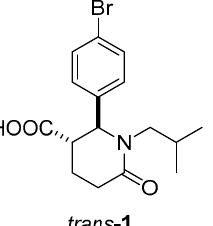
Figure 3. Structure of trans -2-(4-bromophenyl)-1-isobutyl-6-oxopiperidin-3-carboxylic acid ( trans - 1 ).